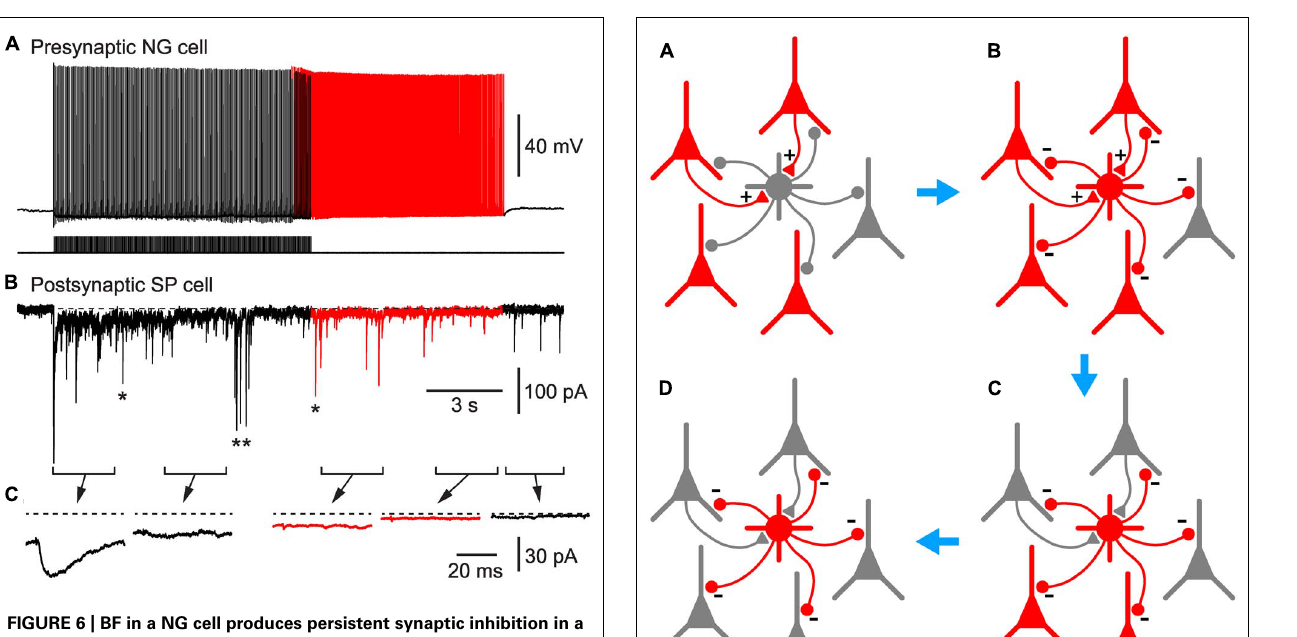
FIGURE 6 | BF in a NG cell produces persistent synaptic inhibition in a nearby superficial pyramidal (SP) cell in an acute slice of the piriform cortex. (A) , Induction of BF (red portion of trace) by depolarizing current steps (20 Hz, 1.4 nA for 2 ms) in a layer 3 NG cell. (B) , IPSCs recorded in a SP cell that is postsynaptic to the NG cell in (A) . Red portion of trace corresponds to the period of BF in the presynaptic NG cell. In addition to the IPSCs generated by the presynaptic NG cell, isolated spontaneous IPSCs (e.g., *) or bursts of IPSCs (**) arising from other interneurons are also present. (C) , Spike-triggered averages of IPSCs recorded during each of the 2.5 s-long periods shown in (B) . Dashed horizontal line indicates the baseline prior to stimulation.